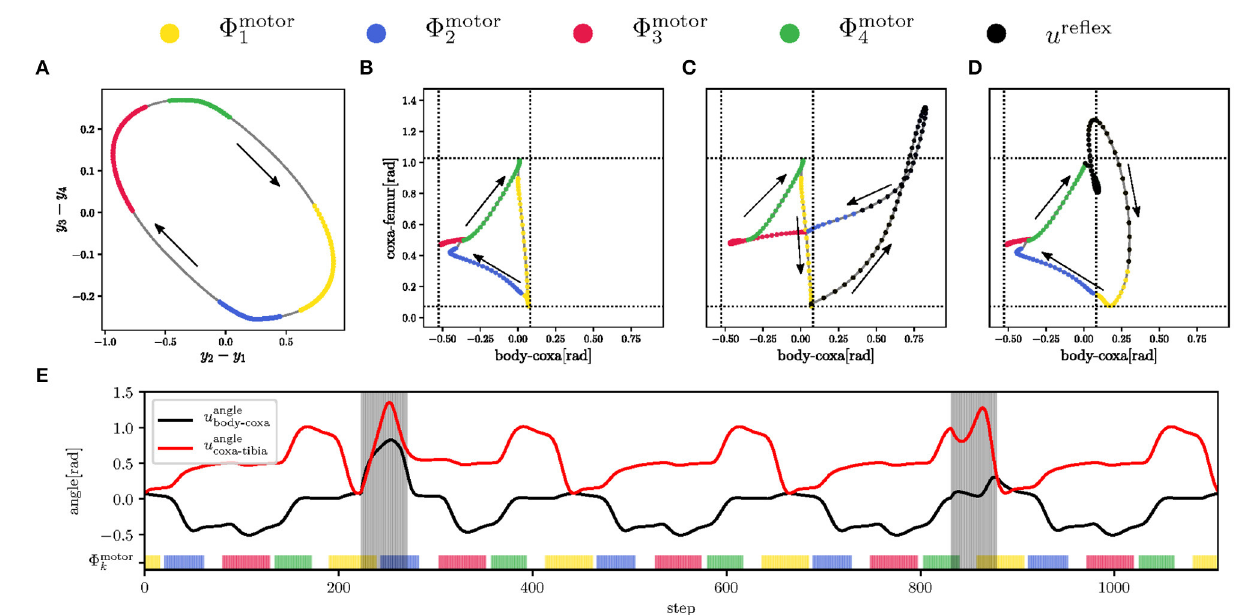
FIGURE 7 | The regular and reflex motions of the left front leg during late swing 8 motor 1 (in the yellow), early stance 8 motor 2 (in the blue), late stance 8 motor 3 (in the red), and early swing 8 motor 4 (in the green). (A) The limit cycle Y motor generated by the motor CPG of the front left body-coxa joint. The duration of each motor phase 8 motor i is projected on the limit cycle, which trajectory direction is indicated by black arrows. The motion phases determine the joint angle control. (B) The regular triangular leg trajectory. At the end of the late swing 8 motor 1 , the leg pokes the ground. (C) The search reflex triggered at the end of the late swing. The leg tries to grasp for support in the protraction direction. (D) The elevator reflex triggered shortly after early swing 8 motor 4 . The leg avoids the obstacle from above. (E) Five gait-cycles of body-coxa (black curve) and coxa-tibia (red curve) joint angles during regular motion and the search and elevator reflexes. Both reflexes are highlighted by the gray area, where the search reflex starts at 222 step, and the elevator reflex starts at step